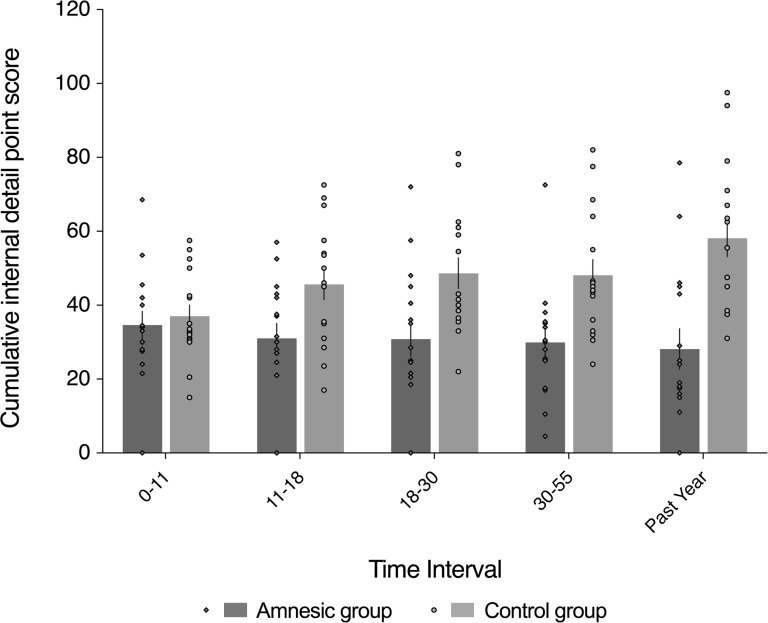
Loss of internal (episodic) detail in the amnesic group for recent and remote memories (up to ~50 years prior to the CA3 damage).Plot depicts mean cumulative number (summed across the general and specific probes) of internal (episodic) details generated on the AI across the five sampled intervals, as a function of group (amnesic group, N = 16; control group, N = 16). With the exception of the past year, each time interval refers to the age of the participant at the time of the remembered event; for example, 18–30 years refers to an event that occurred when each participant was between 18–30 years-of-age. A significant interaction between group and time (across all five sampled intervals) suggests that the loss of internal (episodic) detail was time-sensitive (F(2.67,80.22) = 3.91, p=0.015, η2p = 0.115). Post hoc analyses revealed that the earliest remote memory (0–11 years) was intact (F(1,30) = 0.250, p=0.621), whereas there was temporally ungraded loss of internal detail across the remaining remote and recent memories (group: F(1,30) = 23.25, p<0.0001, η2p = 0.437; group x time: F(2.62,78.44) = 1.51, p=0.222, η2p = 0.048; time: F(2.62,78.44) = 0.604, p=0.592, η2p = 0.020), extending up to ~50 years prior to the CA3 damage (11–18 year interval for internal detail, F(1,30) = 6.43, p=0.017). Error bars correspond to the s.e.m.